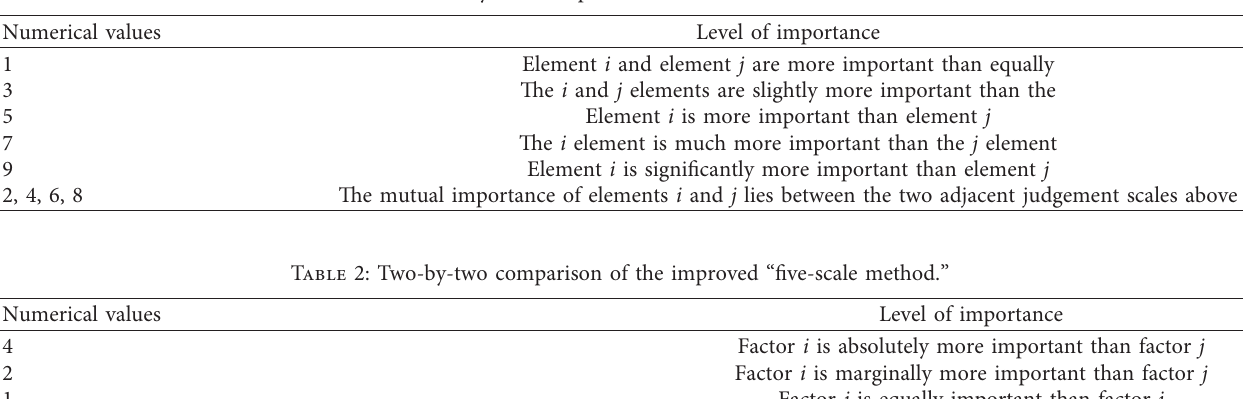
Table 1: Two-by-two comparison of the “nine-scale method.”